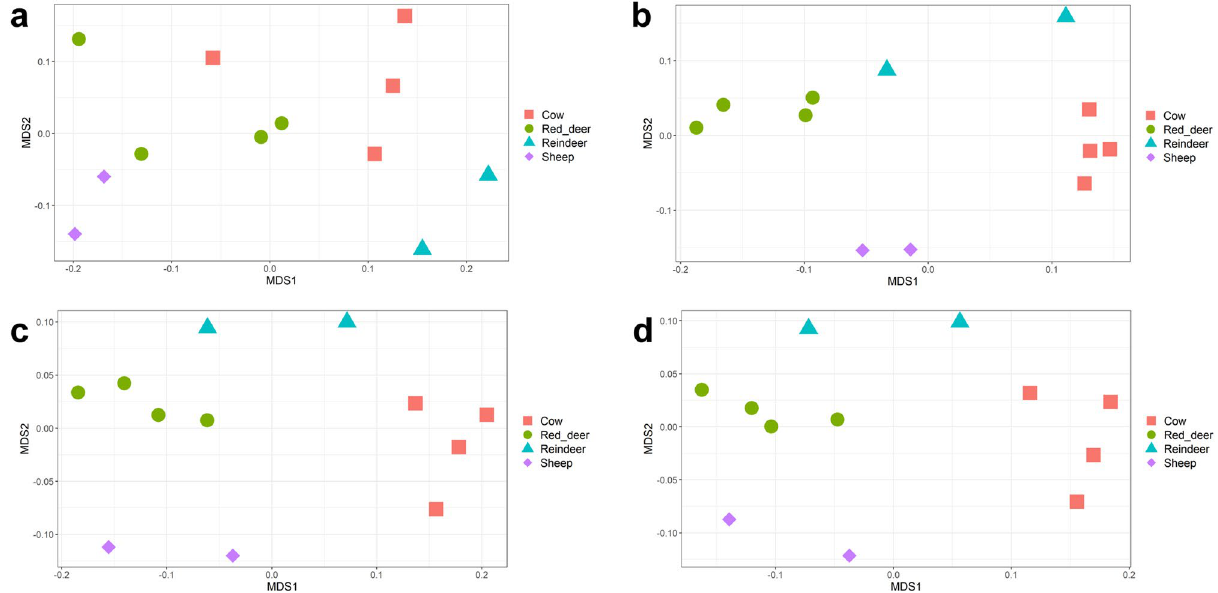
Figure 4. NMDS of ruminal samples clustered by abundance of taxonomies, using Bray–Curtis dissimilarity values. ( a ) Kingdom (PERMANOVA; P = 0.01058), ( b ) Phylum (PERMANOVA; P = 0.00017), ( c ) Family (PERMANOVA; P = 1e−05), ( d ) Genus (PERMANOVA; P = 3e−05).